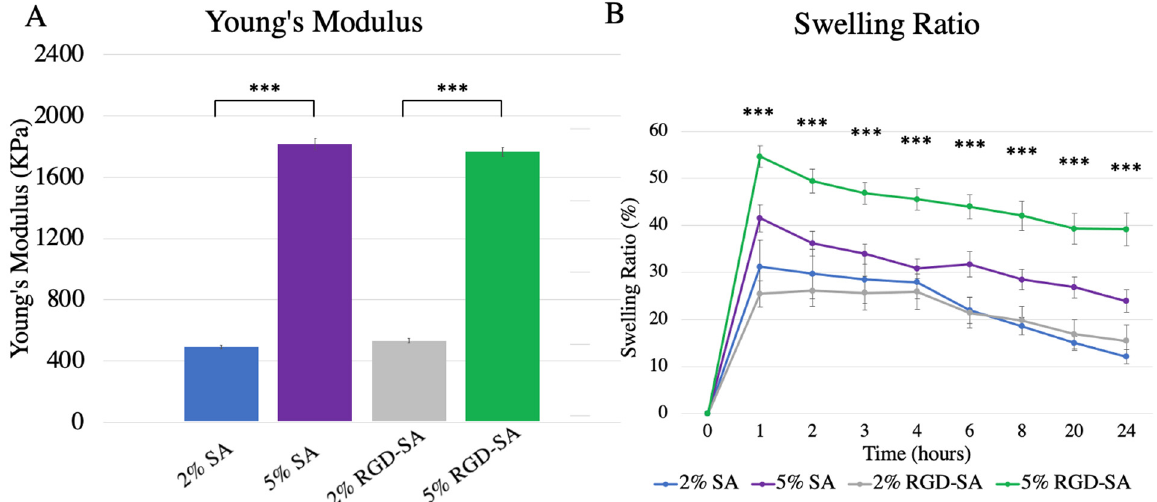
Figure 2. Physical properties of alginates. ( A ) Mechanical tensile testing performed for four different alginates demonstrated significantly different Young’s Modulus ( p < 0.0001) with 5% ( w / v ) sodium alginates, with or without RGD modification, demonstrating statistically significantly higher Young’s Modulus compared to 2% ( w / v ) alginates with or without RGD modification. ( B ) Swelling ratio increased within the first hour for all alginates, but steadily decreased over the course of 24 h. At each time point, swelling ratios of different alginates were significantly different from each other with 5% RGD-SA demonstrating the highest swelling ratio amongst all alginates. * denotes p < 0.05; ** denotes p < 0.01; *** denotes p < 0.001. SA: sodium alginate; RGD-SA: RGD-modified sodium alginate. Error bars represent standard error.